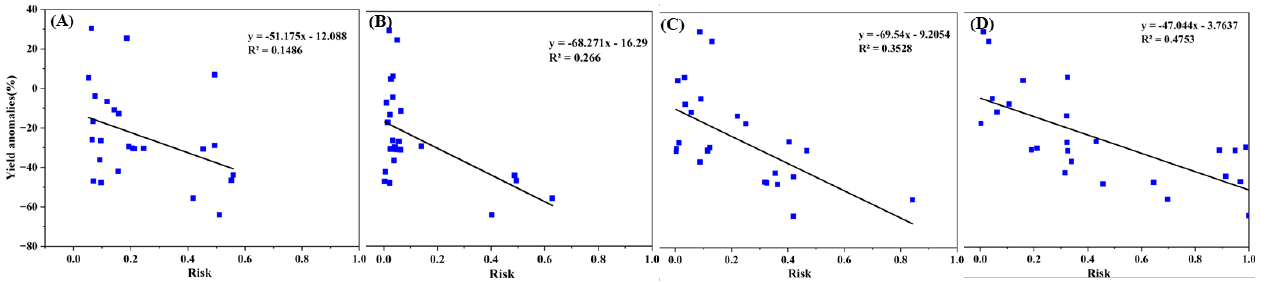
Figure 12. Spatial change in the drought disaster risk of sugarcane in Guangxi. ( A – D ) represent the stages of seedling, tillering, stem elongation, and maturity, respectively.